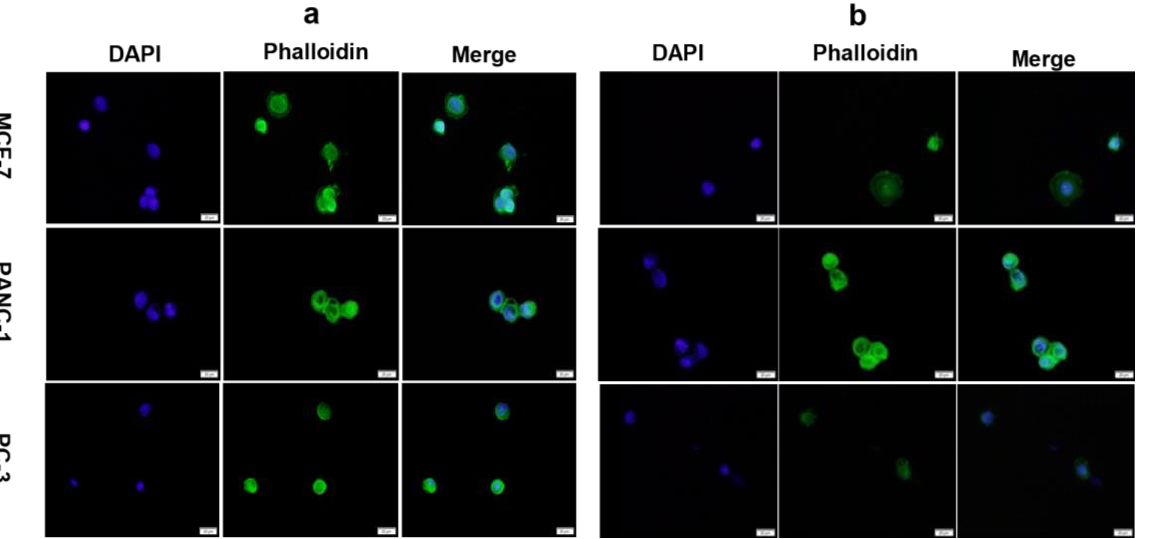
Figure 7. Fluorescence images of three different cancer cell lines attached and fixed to ( a ) 6 MHz keyhole QCR and ( b ) 9 MHz ring electrode QCR with an incubation time of 30 min and a magnification of 40×. The images represent a random area (scale of 20 microns) on the active regions of the quartz crystals and do not represent the total number of captured cells.